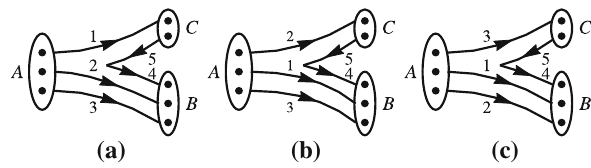
Fig. 2 The baryon decay process A → B + C in the 3 P 0